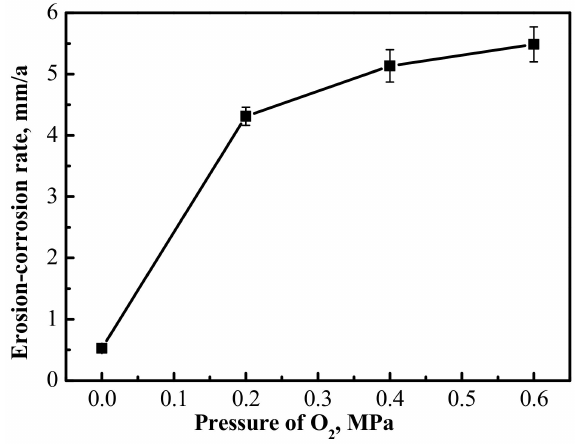
Figure 4. Average erosion-corrosion rate of 3Cr